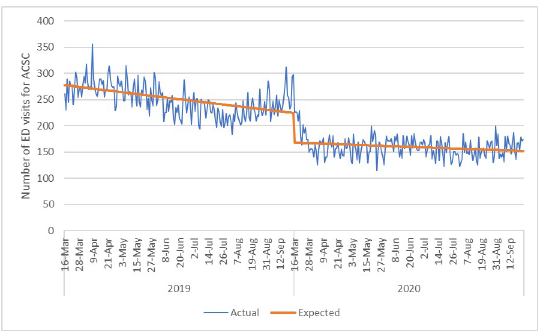
Fig 4. Number of emergency department visits per day for ambulatory care sensitive